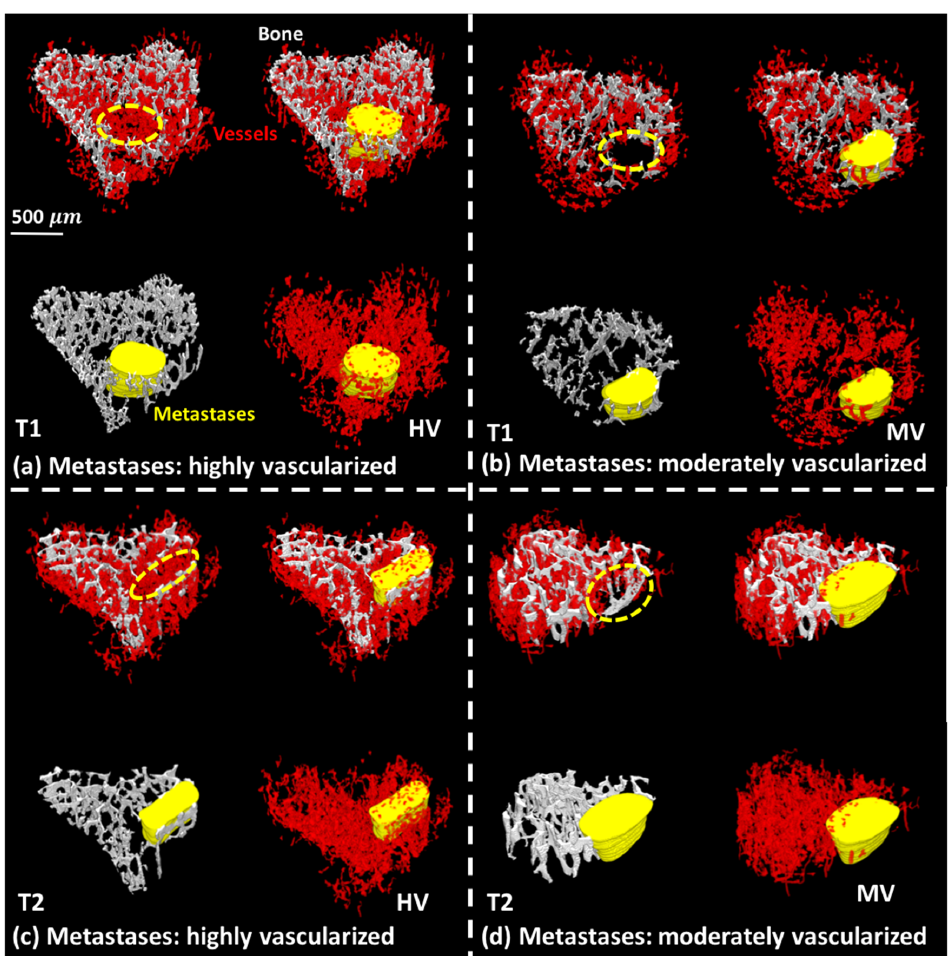
Figure 7. Illustration of spatial relationships between metastases (yellow) on trabecular bone (gray) and blood vessels (red). T1, metastases: ( a ) highly vascularized (HV), ( b ) moderately vascularized (MV); T2, metastases: ( c ) highly vascularized (HV), ( d ) moderately vascularized (MV).